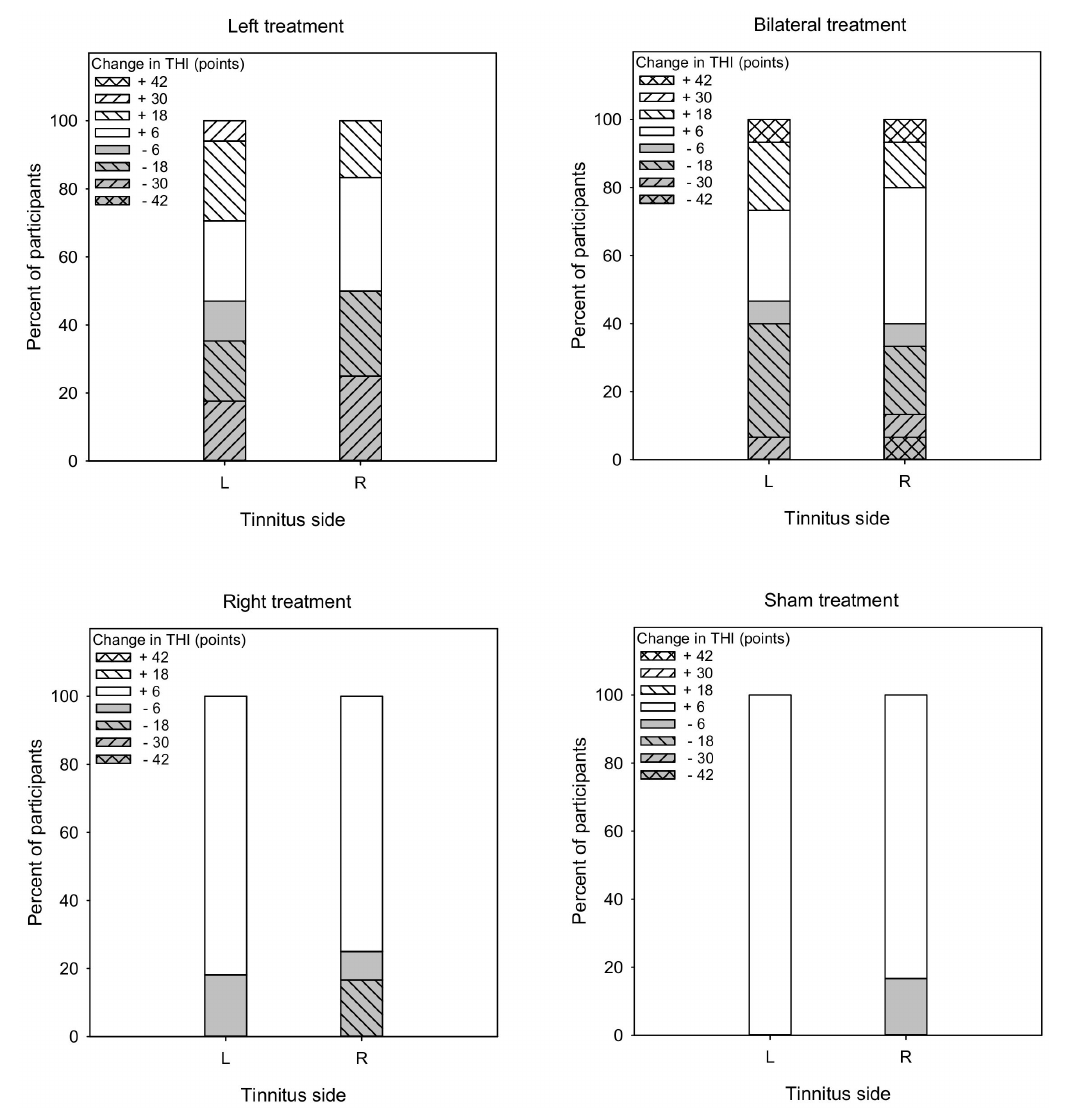
Figure 8. Vertical stacked bar charts showing the percentage of patients with various ranges of post- treatment changes in THI scores the Left, Right, Bilateral, and Sham treatment groups. Reductions >6 points were considered to be responders (gray bars), and reductions <6 points were considered non-responders (white